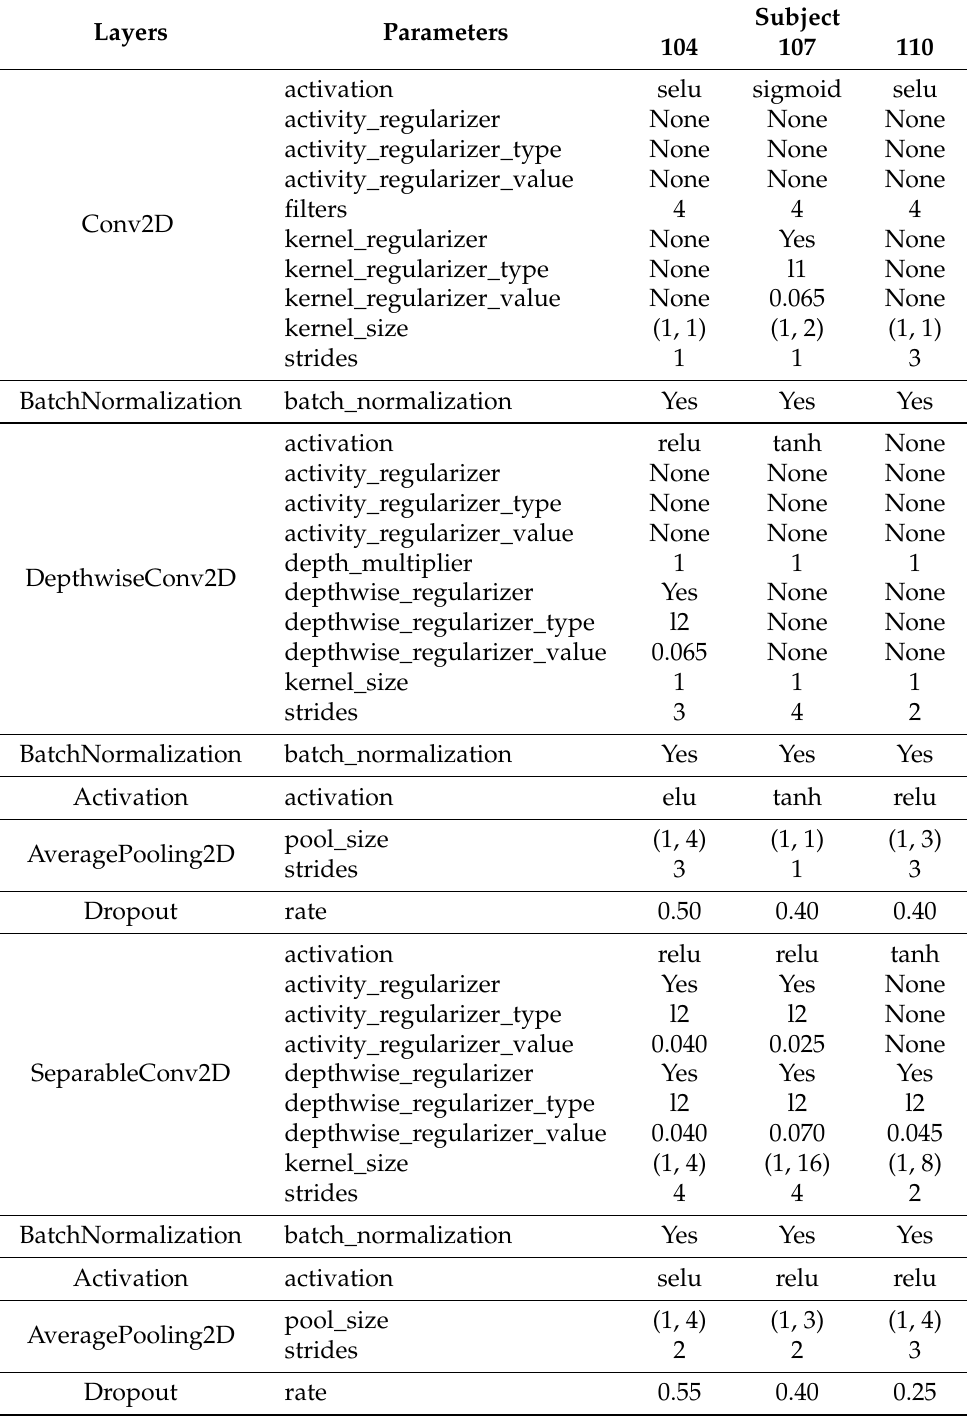
Table 3. Models corresponding to the trade-off point (solution) in the corresponding Pareto front.